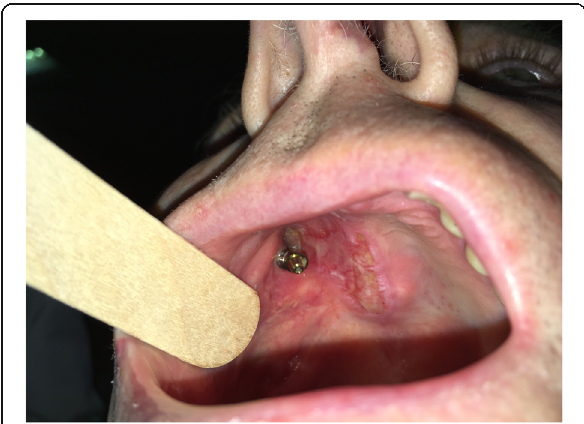
Fig. 15 Pt no. 3. Intraoral view after 1 month